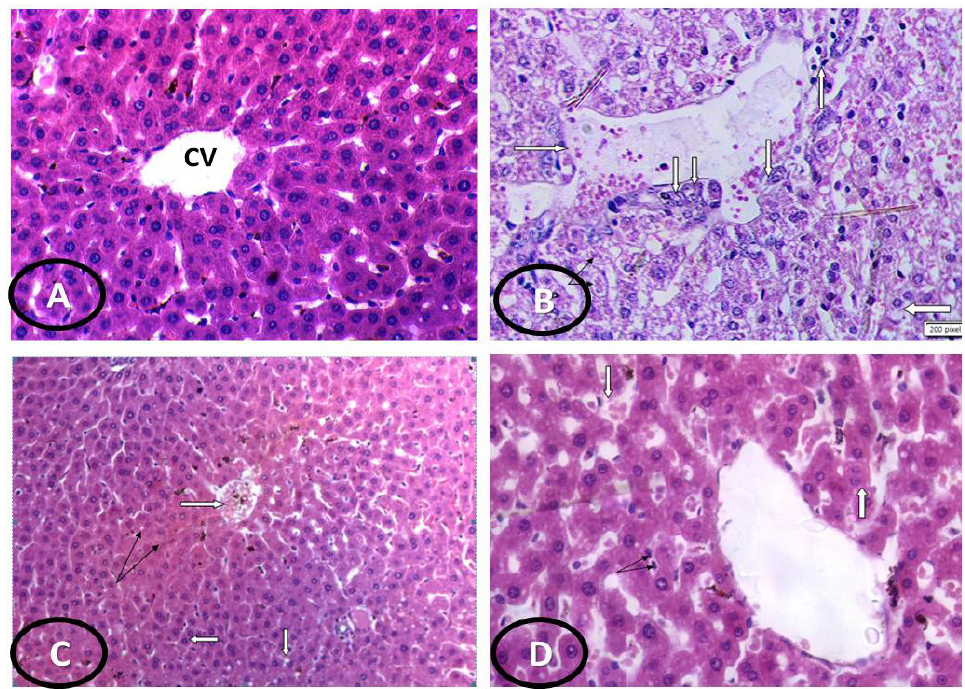
Figure 3. ( A ) Control group showing normal hepatic structure and normal nuclei (H&EX400). ( B ) D-galactose-treated group showing experimental rat liver after treatment with CdCl 2 with marked toxicity in the form of dilatation, elonga- tion, irregularity of the portal vein ( ), hypertrophy of hepatocytes with the appearance of binucleated hepatocytes and hydropic degeneration of hepatocytes with vesicular nuclei ( ), Ductular reaction with new bile duct formation ( ), appearance of mummified cells ( ), and infiltration by inflammatory cells ( ) (H&EX400). Figure ( C ): Zn/Q-treated group showing normal hepatic structure with normal nuclei (H&EX400). Figure ( D ): CdCl 2 and Zn/Q-treated group showing great improvement and restoration of hepatic structures with mild changes in the form of hypertrophy of hepatocytes with granular eosinophilic cytoplasm and vesicular nuclei and appearance of some binucle- ated cells ( ), with a slightly dilated central vein lined by endothelial cells and dilated congested blood sinusoids ( ), some of which have been infiltrated by mononuclear inflammatory cells ( ) (H&EX400). The histological index for scoring the hepatic structural alterations is shown in Table 4.